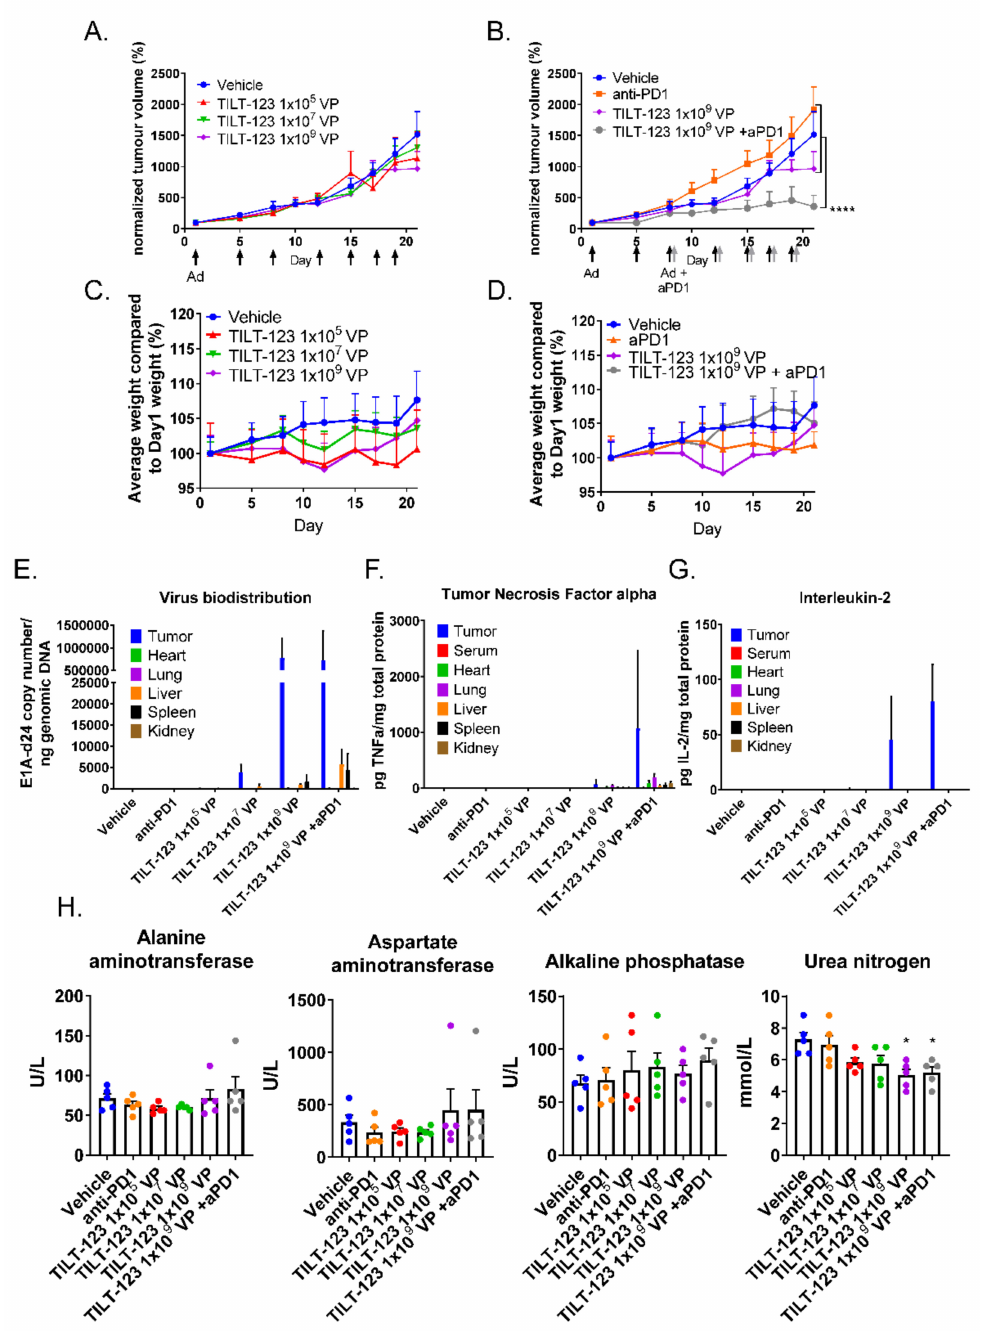
Figure 6. Mice treated with TILT-123 and anti-PD-1 show tumor growth reduction. Nude mice bearing subcutaneous human fibrosarcoma tumors received TILT-123 (black arrows) and anti-PD-1 treatments (grey arrows) twice a week. Anti-PD-1 treatments started on day 7 and were given i.p. The first virus injection was given i.v., and the rest was given i.t. Tumor size was measured with a digital caliper ( A , B ), and animals were weighed ( C , D ) two to three times a week. Tumor size and animal weight at the beginning of the treatment period was set to 100%. Adenovirus genomes were detected from the tumors and healthy tissue samples ( E ) by qPCR and normalized against the genomic DNA amount or sample volume. TILT-123 transgenes human TNFa ( F ) and human IL-2 ( G ) were analyzed from tumors and healthy tissue samples with ELISA and were normalized to total protein contents in the samples. ( H ) Whole blood was collected from mice 48 h after last treatment (day 20). The serum was separated after blood coagulation. The data show mean plus standard error of mean. Statistical significance was evaluated with the log-linear mixed models analysis (tumor growth and weight development) or with one-way ANOVA. * p < 0.05; **** p < 0.0001; Ad = TILT-123 injection; aPD1 = anti-PD-1; VP = Virus